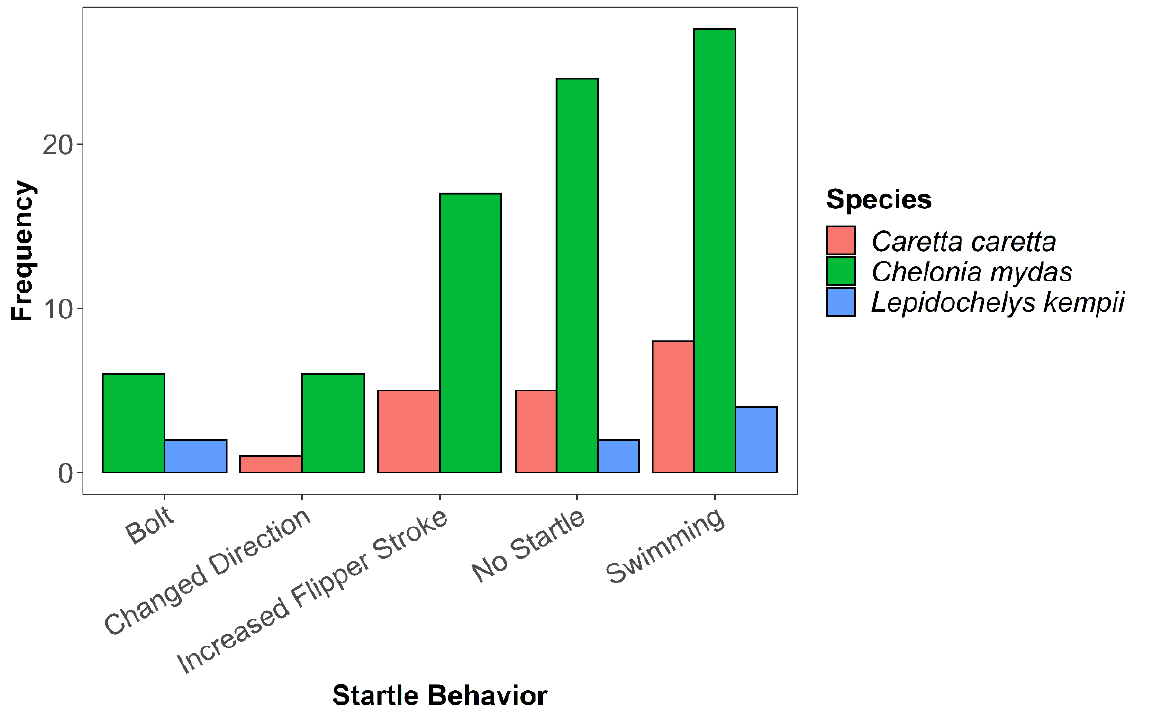
Figure 4. Frequency of startle behavior type across three species of sea turtles observed at study sites.